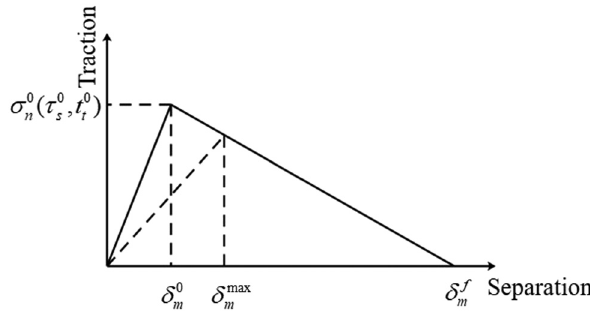
Figure 1: Traction – separation law of a cohesive